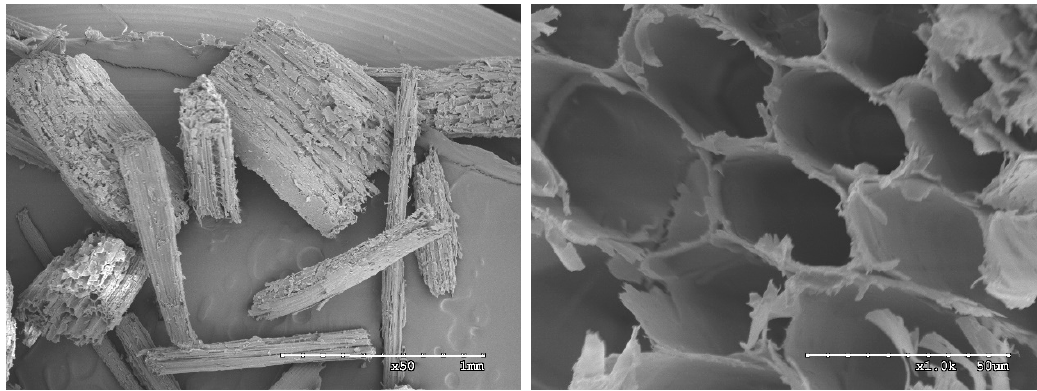
Figure 6. SEM micrographs of the raw wheat straw .